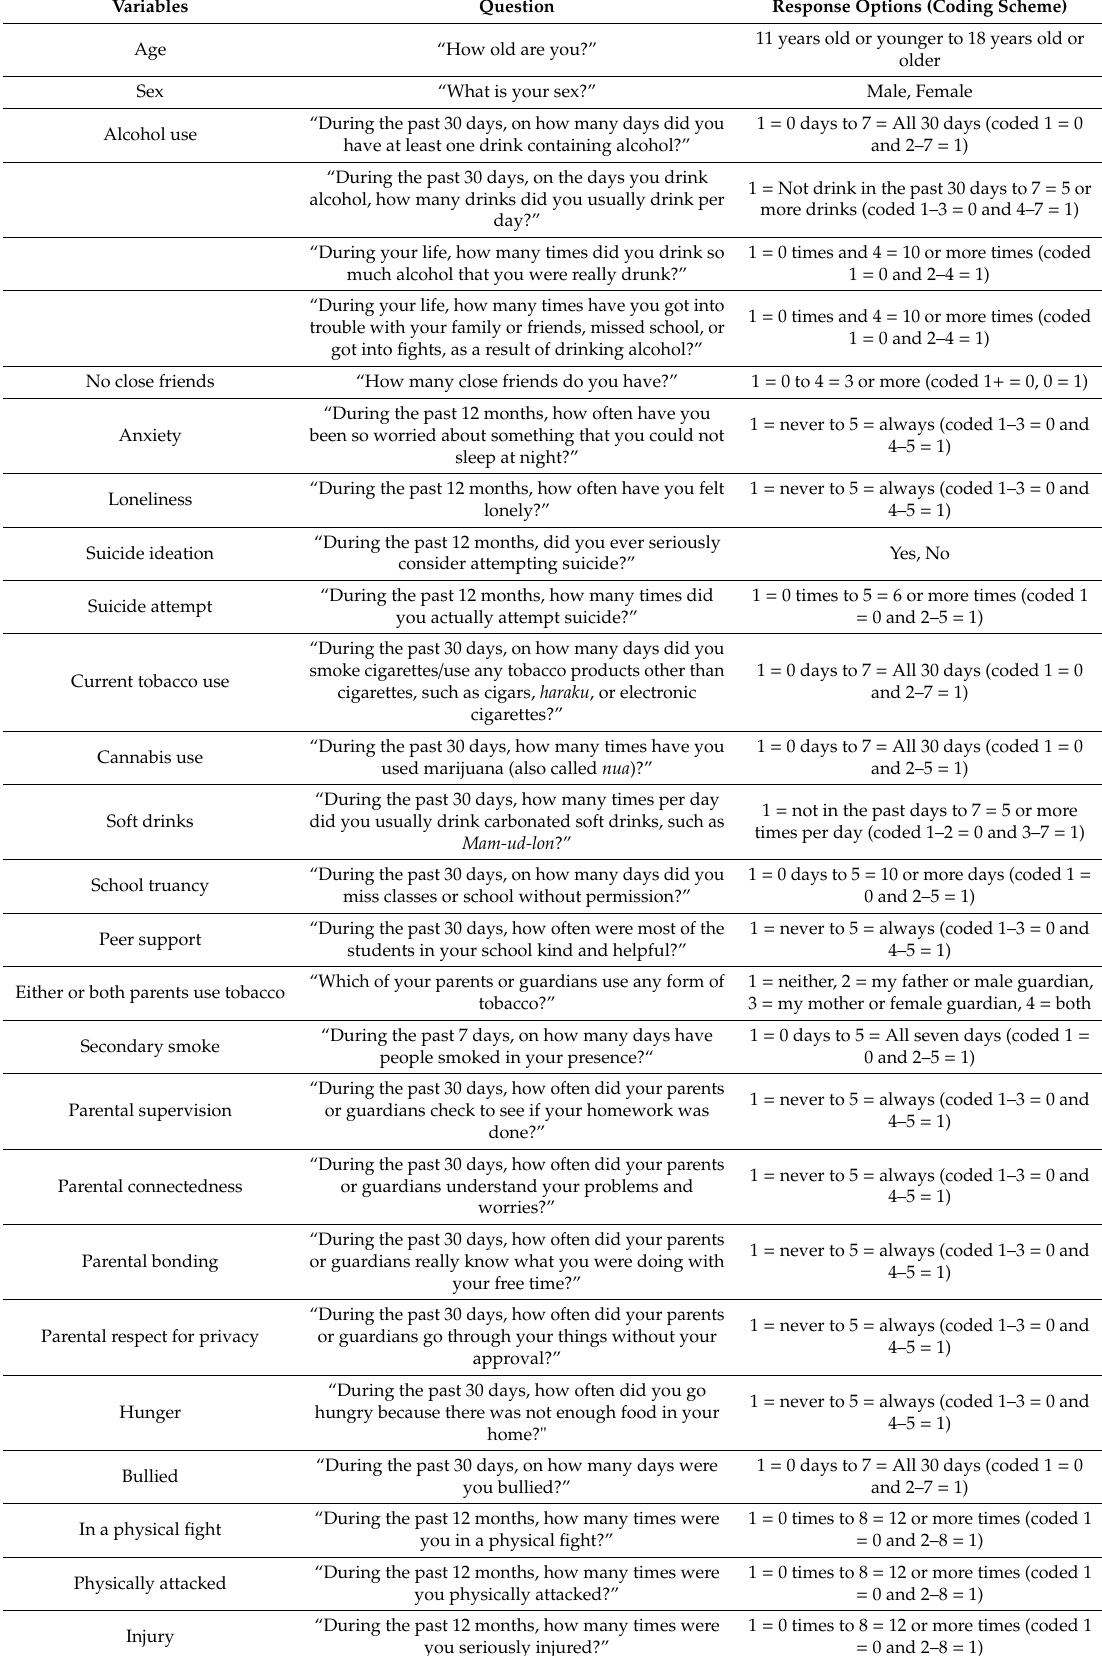
Table 1. Variable